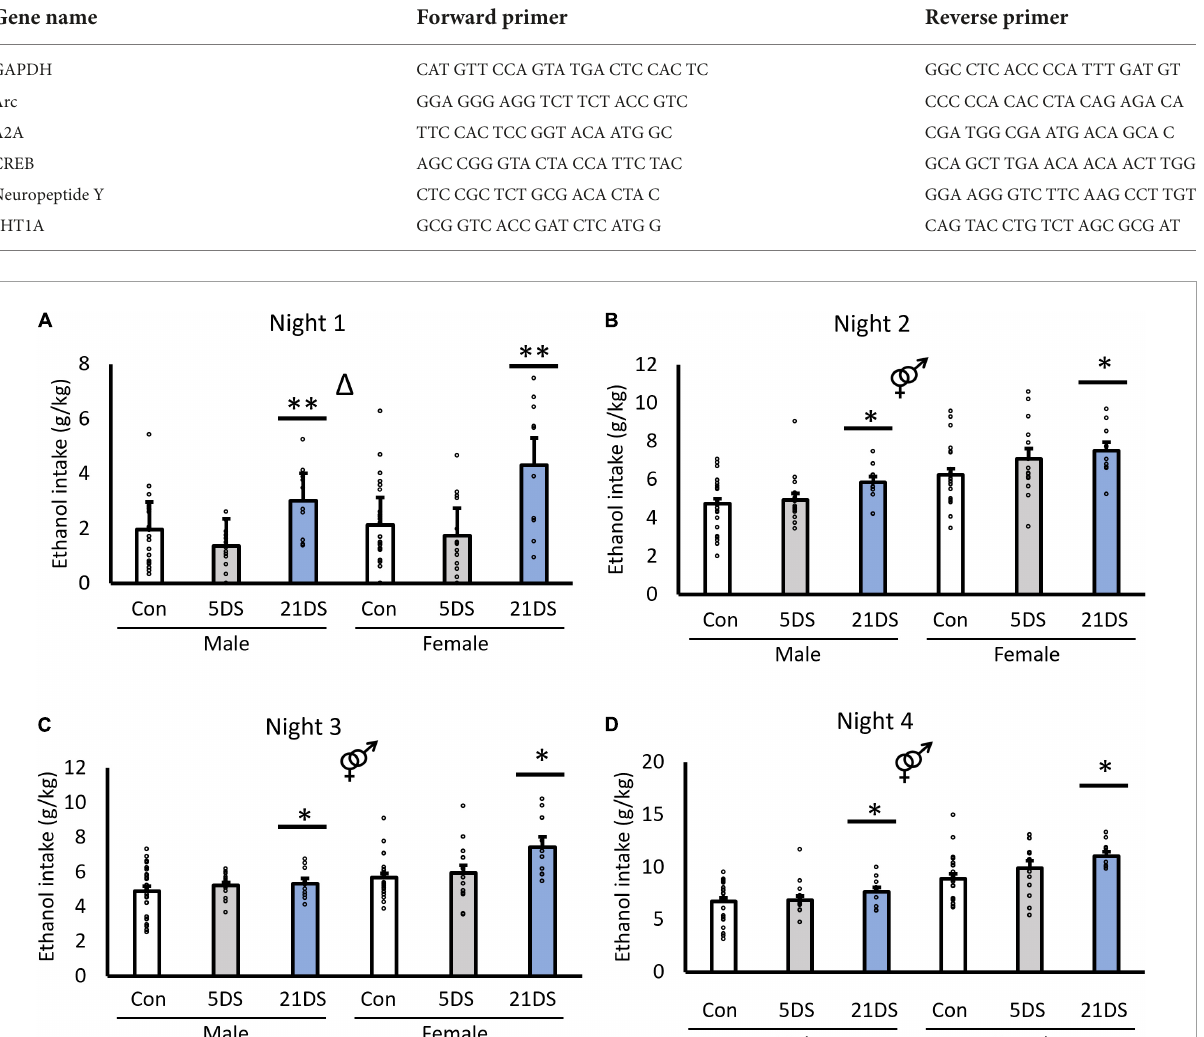
FIGURE1 Chronic stress (21DS), but not sub-chronic stress (5DS), significantly increases binge-like alcohol consumption in male and female mice. Nightly alcohol intake using the drinking-in-the-dark test is shown for night 1 (A) , night 2 (B) , night 3 (C) , and night 4 (D) . N = 25–26 for the